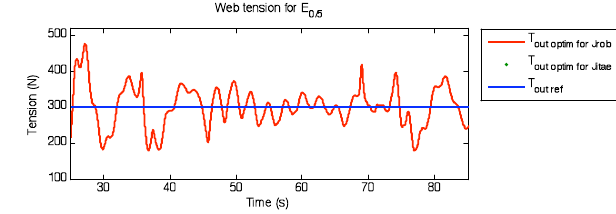
Fig. 15. Optimized PI controllers simulation results for or using switching strategy (for